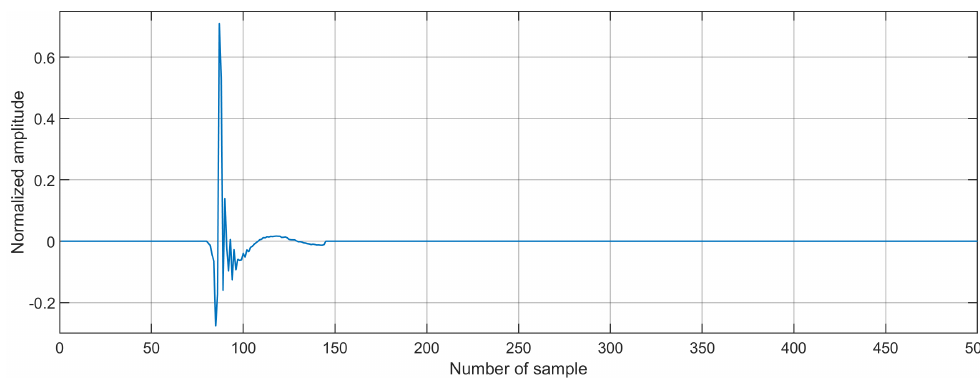
Figure 4. Acoustic echo path used for the simulation of the existing and the proposed algorithms.